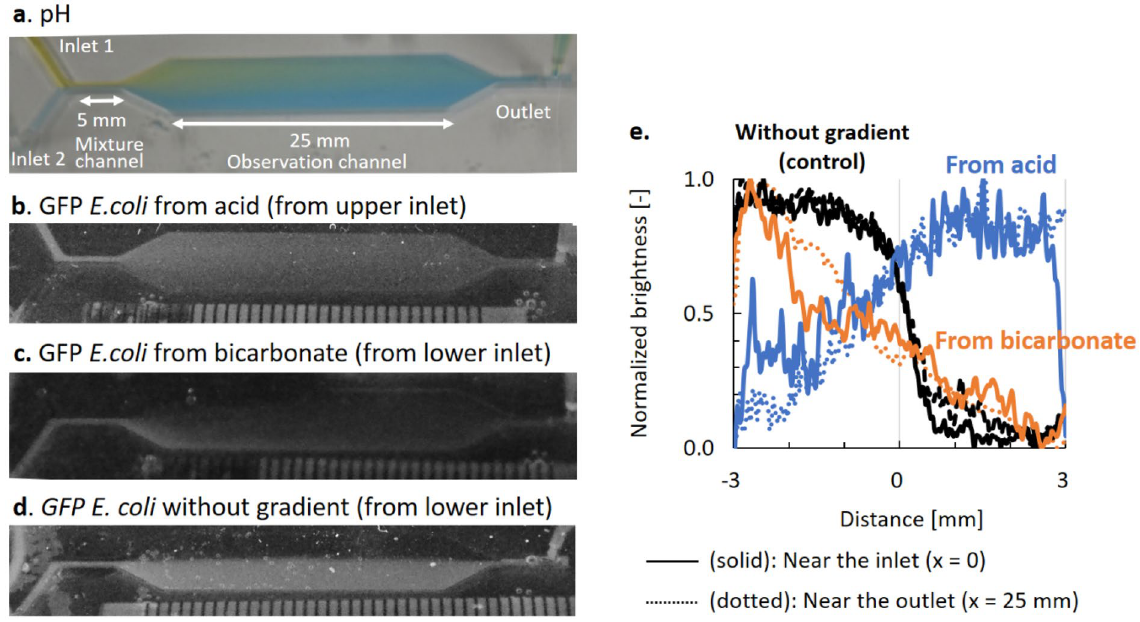
Figure 6. A steady pH gradient is generated in a microfluidic device, with pH at 5–6 at the top and 7–8 at the bottom ( a ). GFP E. coli were attracted away from the upper channel with a lower pH toward the lower part with neutral pH ( b , c, e blue and orange), though bacteria migrated vertically little without gradient ( d ). a : pH was visualized in bromothymol blue. b , c : Bacteria were included in either the upper inlet ( b ) or the lower inlet ( c ). d : GFP E.coli migrated little without gradient. e : Distribution of GFP E. c oli in the proximal (dotted) and distal (solid) channels . Photos in b – d were taken in black-and-white mode under black light at 350 pancreatic cancer 10 (Table S1) and visible with their intrinsic fluorescence under UV light. A lower flow rate of 20 μl/min was chosen to easily observe bacterial migration under flow conditions. When P. fluorescens were included in bicarbonate solution at the left cylinder as a control, bacterial distri- bution in the right cylinder did not change over 50 s, suggesting no upstream migration without pH-gradient (Figs. 7b, S10b, and movie S1). This agrees with the simulated migrations that the bacterial concentration due to motility alone dropped to 1/100 at one millimeter after five minutes (Fig. S11b). Note the vertical axis is loga- rithmic scale (Fig. S11b). Then P. fluorescens were included in hydrochloride solution of pH 5–6 to analyze the P. fluorescens migrated upstream against bicarbonate flow (Figs. 7c and S10a, movie S2), with the penetration velocity at approximately 50 μm/s (Figs. 7c, d and S10a). pH taxis of P. fluorescens drove them from acidic solution